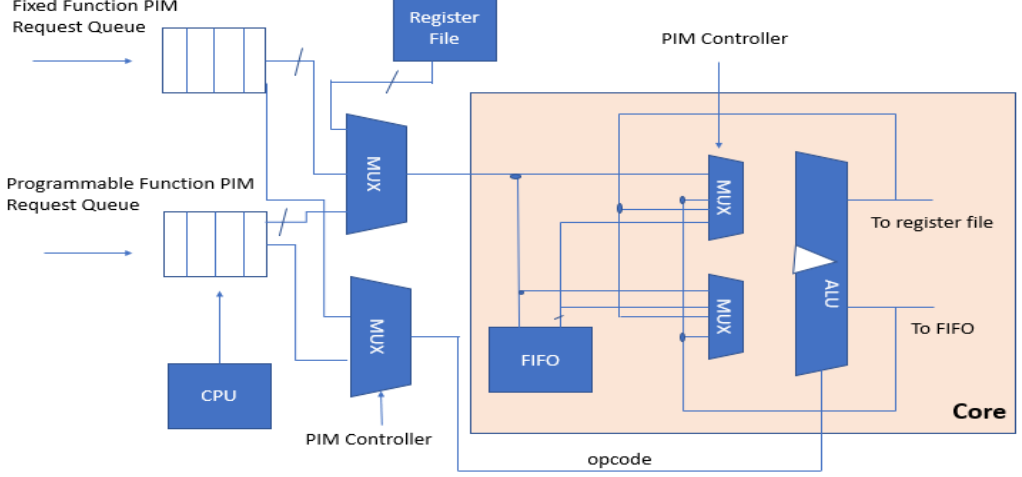
Figure 33. Proposed heterogenous processing-in-memory architecture [17].